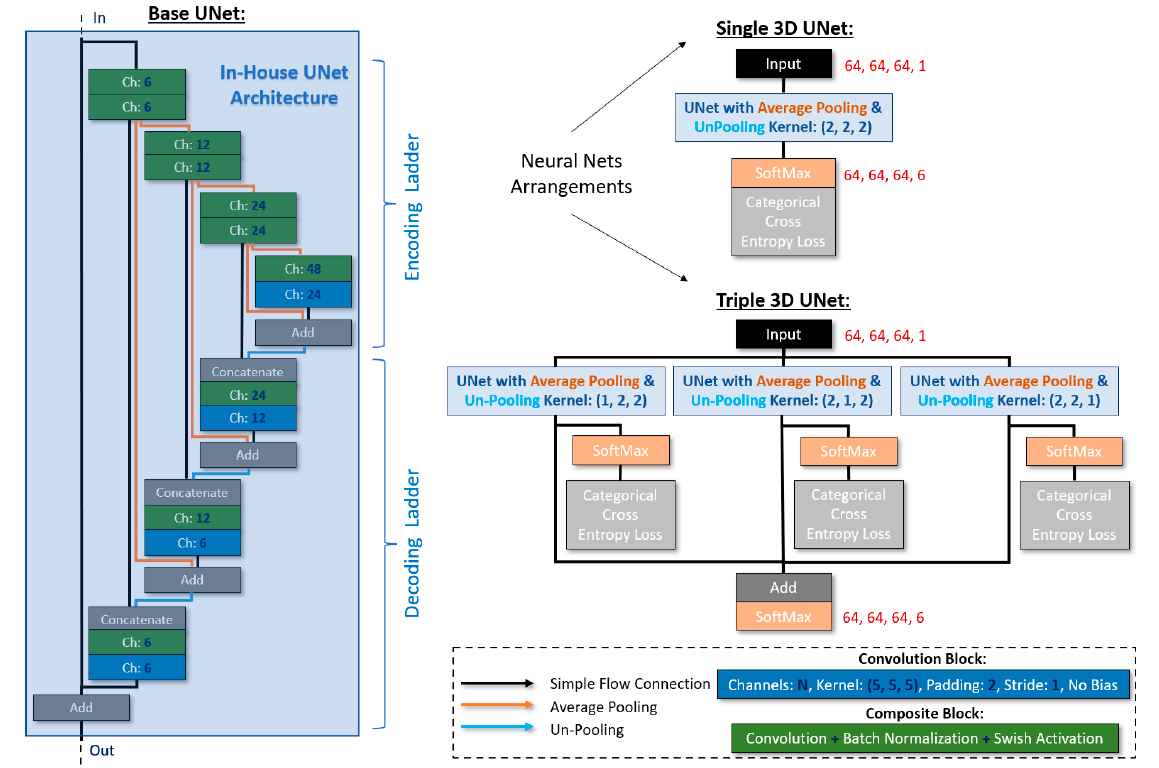
Figure 5. The proposed Single_UNet and Triple_UNet architectures.